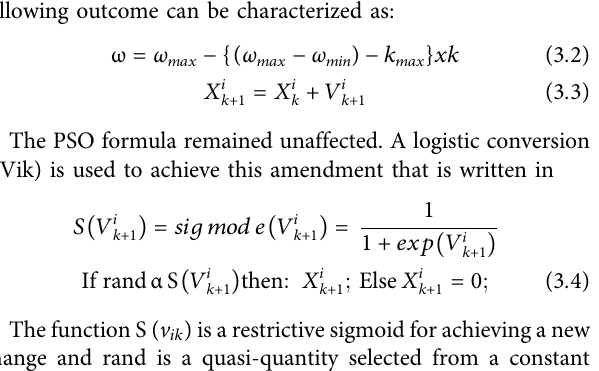
FIGURE 2 | General mechanism of the genetic